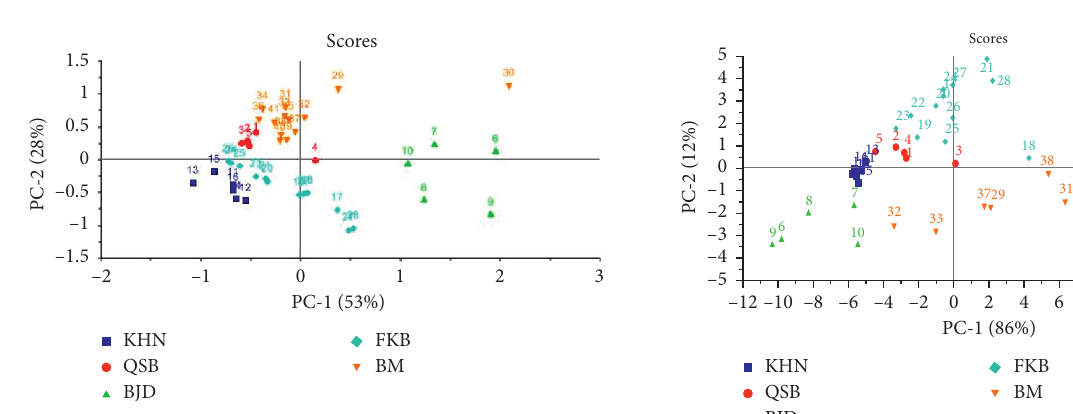
Figure 3: Olive oil UV-Visible spectra corrected by baseline correction.